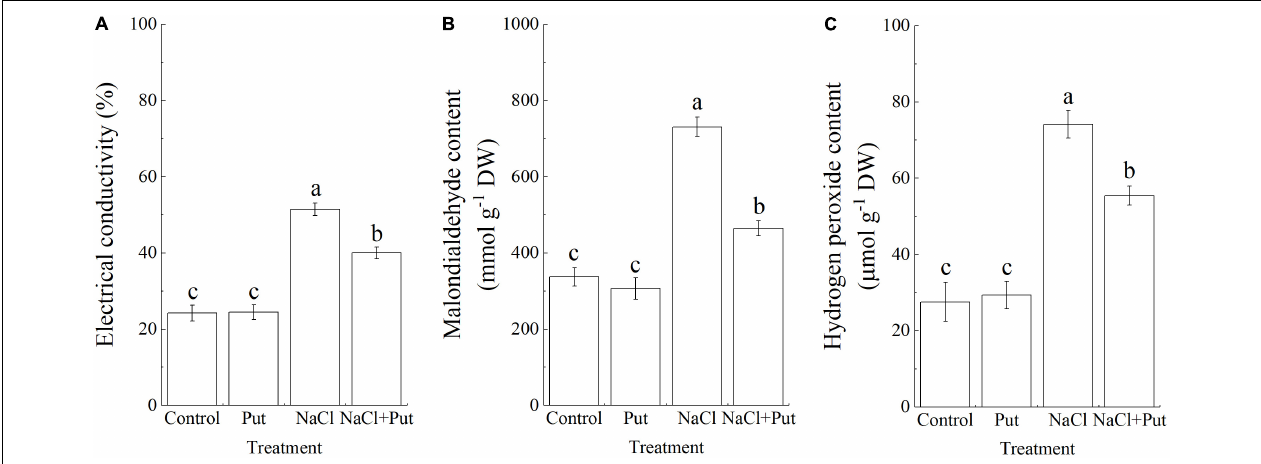
FIGURE 2 | Effects of seed soaking with Put or water on (A) electrical conductivity, (B) malondialdehyde content, and (C) hydrogen peroxide content of white clover seedlings after 7 days of germination under normal condition and salt stress. Vertical bars above columns indicate the standard error of each mean ( n = 4). Different letters indicate a significant difference ( P ≤ 0.05).